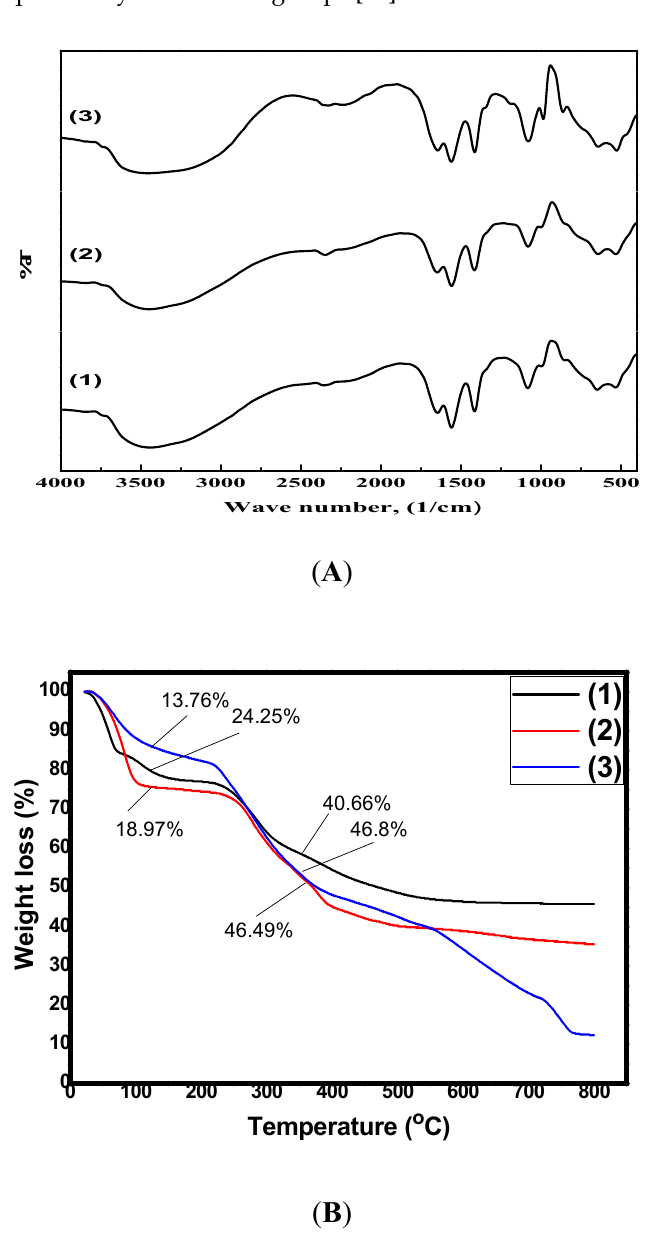
Figure 1. ( A ) FT-IR spectra and ( B ) TGA thermograms of (1) AmCs, (2) Q-AmCs1, and (3) Q-AmCs2 nanoparticles.